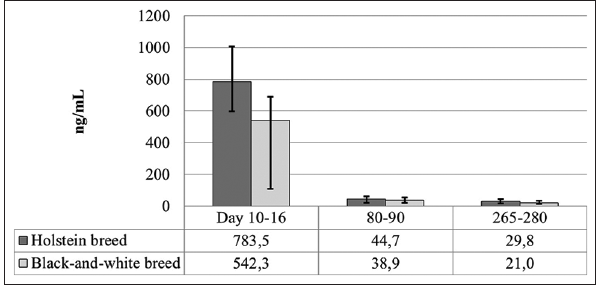
Figure-1: Insulin-like growth factor concentration in bovine milk; n =